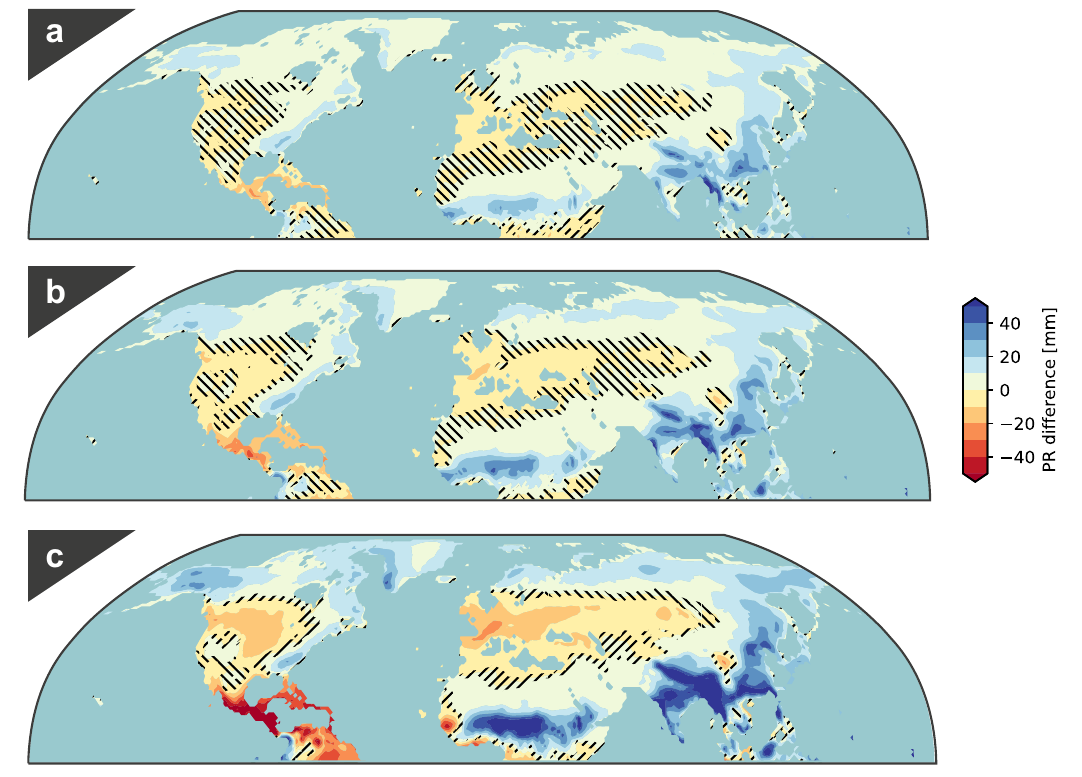
Fig. 4 Changes to summer precipitation under SSP1-2.6, SSP2-4.5 and SSP5-8.5. a – c Averaged anomalies of summer precipitation under SSP1-2.6 ( a ), SSP2-4.5 ( b ) and SSP5-8.5 ( c ) in the Northern Hemisphere. A reference period of 1971 – 2000 relative to the period 2071 – 2100 is used for deriving anomalies. The hatched areas indicate areas with insigni fi cant changes according to the two-sided Student ’ s t test ( p <